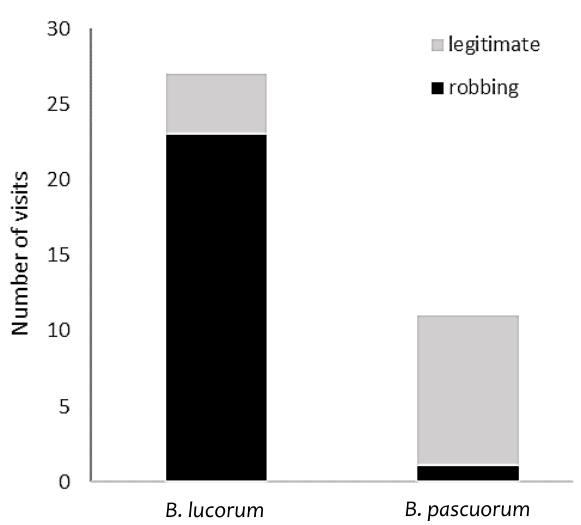
Figure 4. Nectar robbing behavior was only observed at one site: River Corrib. Two species were observed nectar robbing: the medium-tongued B. pascuorum and the short- tongued B. lucorum